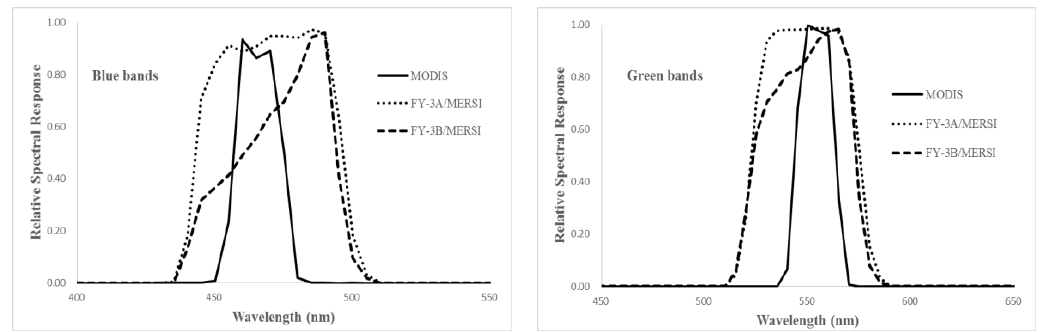
Figure 4. The relative spectral responses of the VIRRs and MODIS in VNIR bands.